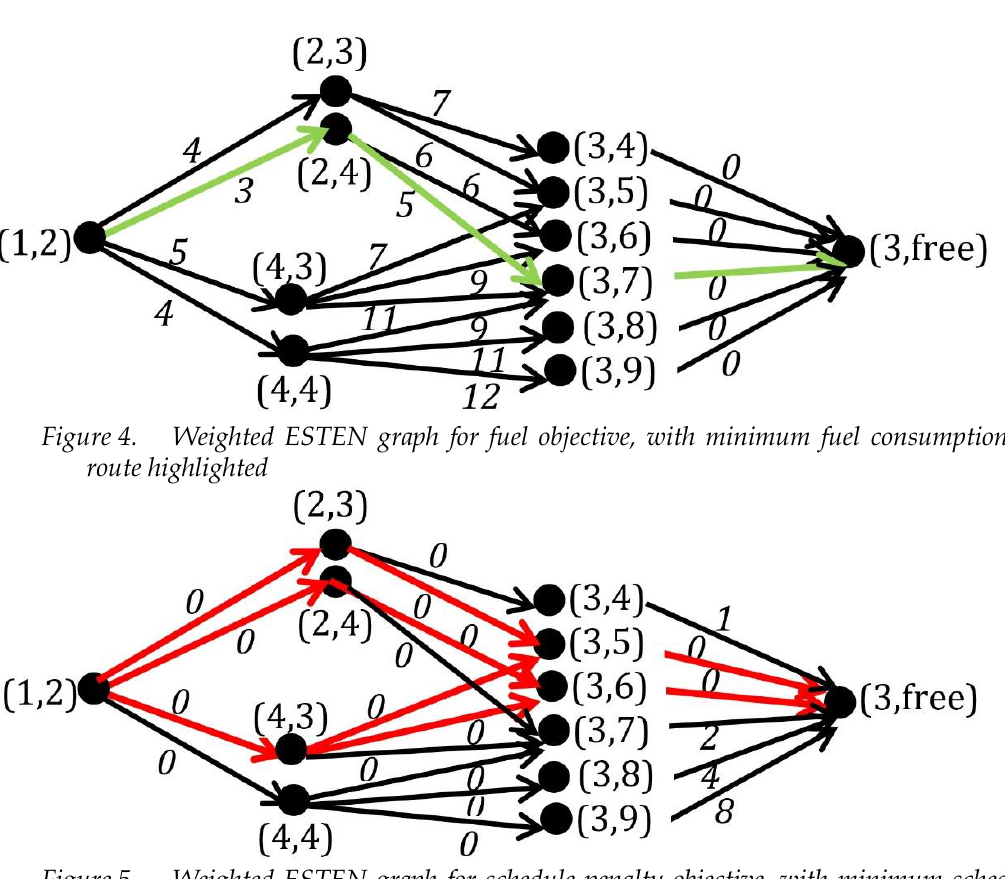
Figure 3. Weighted ESTEN graph for travel time objective, with minimum travel time space-time route highlighted